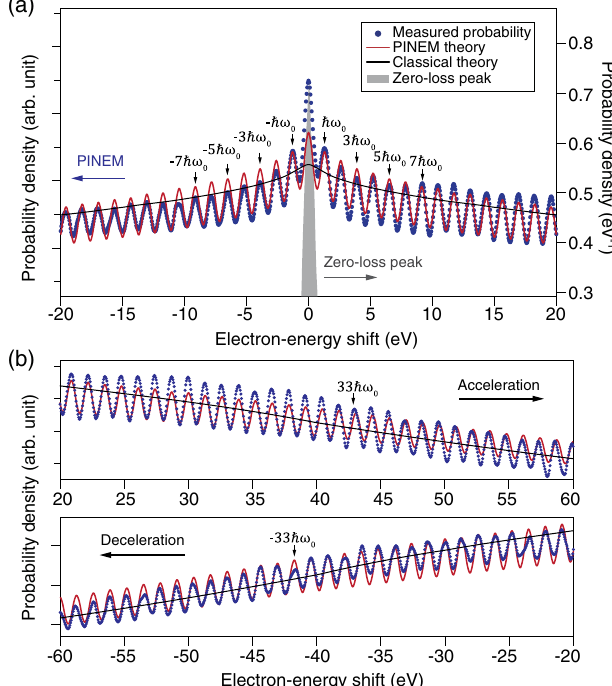
FIG. 4 The quantum nature of electron-laser acceleration observed in a DLA. The electron-energy spectrum after the interaction with the DLA near field shows its quantized nature, as it oscillates with the periodicity of the fundamental photon energy of the incident laser. To reveal this quantum behavior, we perform the same EELS measurement as described in Fig. 3, but we use a finer detection resolution of 0.05 eV which leads to a measured electron coherency of 1.15 eV at FWHM (rms of 0.5 eV). The important change in the detection resolution enables us to probe features that are below sin- gle-photon energy and to reveal the fine features in the spectral shape of each accelerated electron. In the above, we also stretch the duration of the laser pulse relative to the case in Fig. 3 to cover more of the electron wave function by the laser pulse. This causes a larger portion of the electrons to interact, resulting in a lower ZLP (see Supplemental Material [46] for parameters comparison and the relations between the different timescales in the experiment). The theoretical spectrum pro- duced by the extended PINEM theory [solid red line, Eqs. (1) and (2)] matches well with the measured data, unlike the classical theory (black solid line), which is calculated with the classical formula appearing in the text below Eq. (1) (see also the Supplemental Material [46]). The horizontal error for each point on the measured curves is determined by the measured initial energy width of the electron beam (0.5 eV) and by the detector resolution ( (cid:4) 0 . 05 eV).